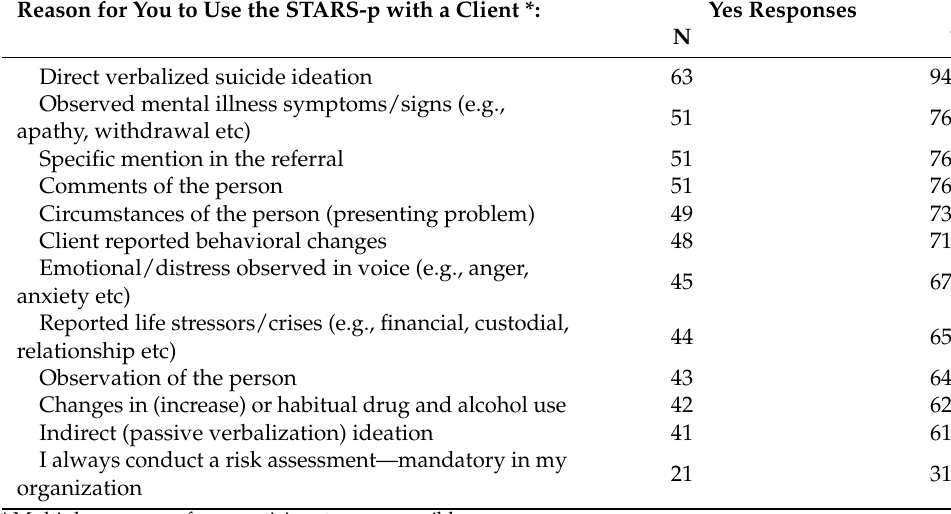
Table 3. Reasons for the use of